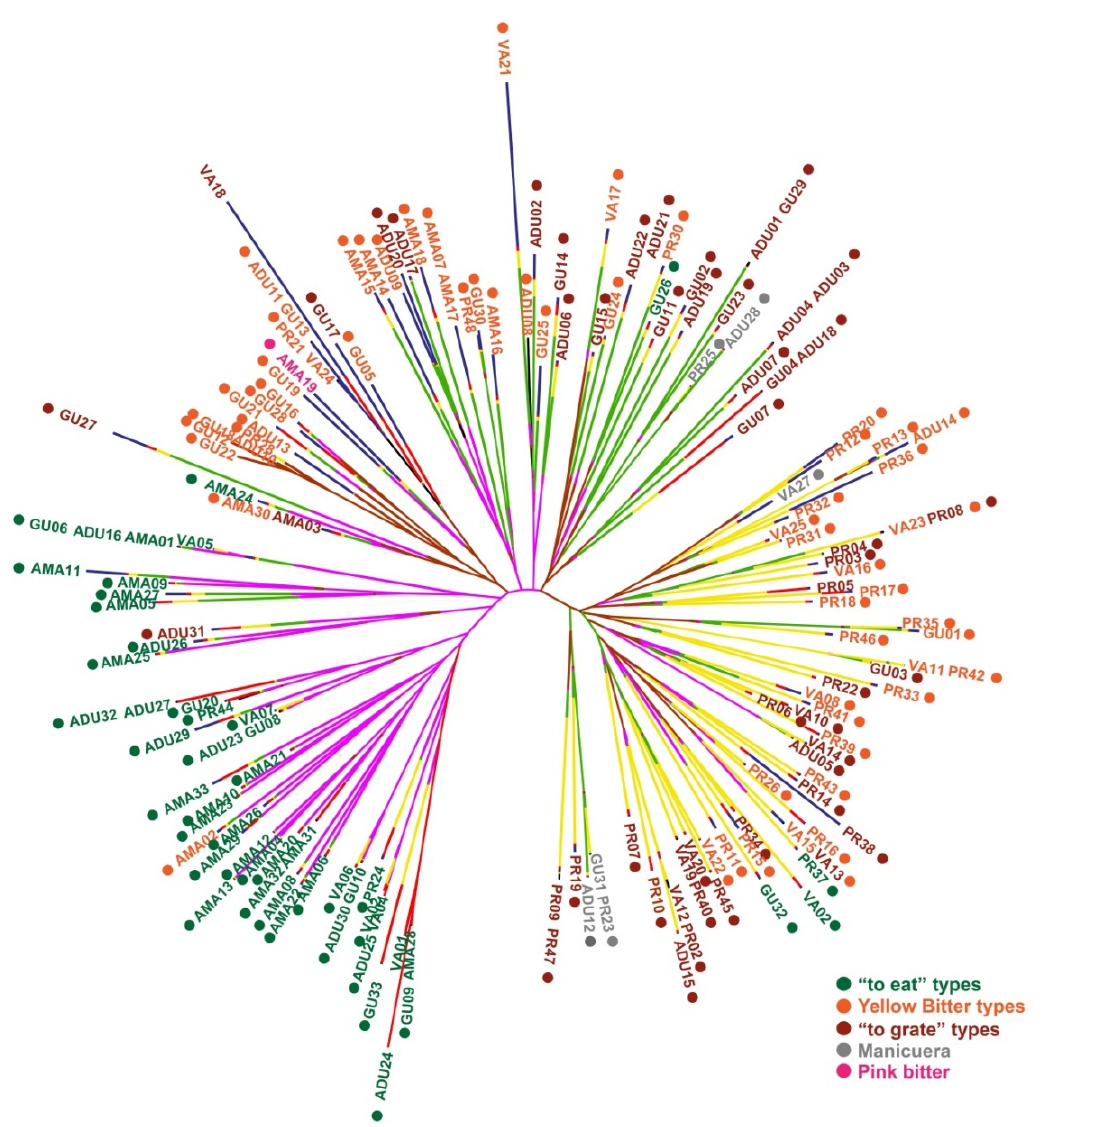
Figure 2. Genetic distribution of manioc landraces according to their toxicity. ( A ) Neighbor-Joining dendrogram showing the genetic relation of the different manioc types identified by indigenous people; ( B ) STRUCTURE output of the molecular diversity of sampled maniocs according to their toxicity as sweet (low toxicity) and bitter (high toxicity) maniocs obtained with the most likely number of clusters (K = 3 and K = 6). Each vertical colored bar represents one genotype and the colors indicate the extent to which a genotype genetically belonged to the